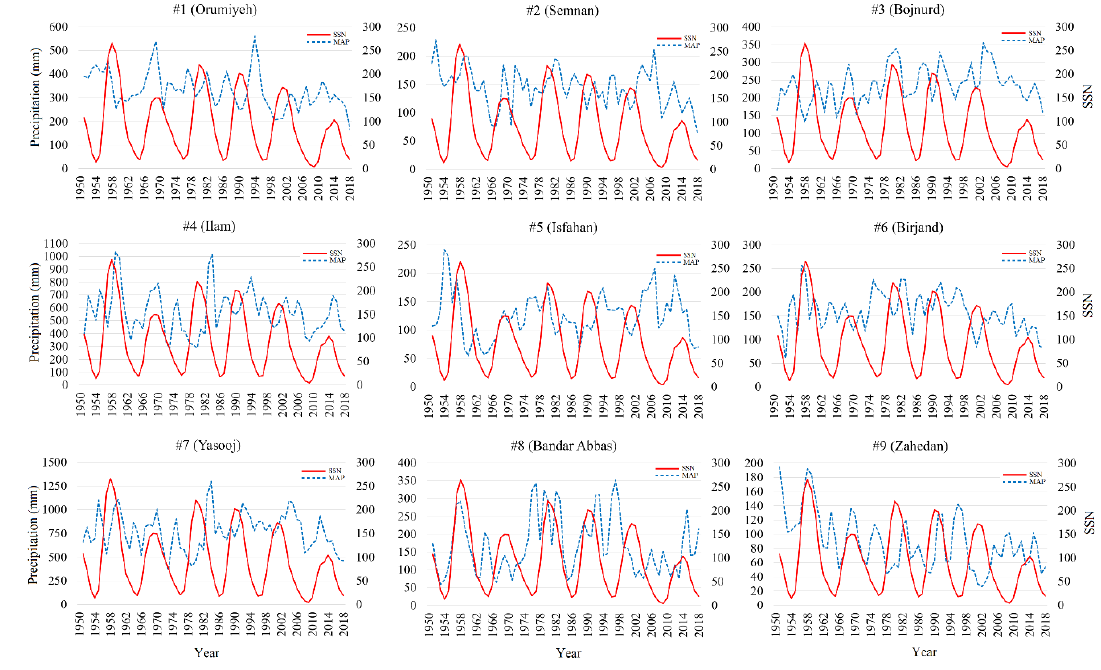
Figure 3. Mean annual precipitation (MAP) and SSN time series [35,36].